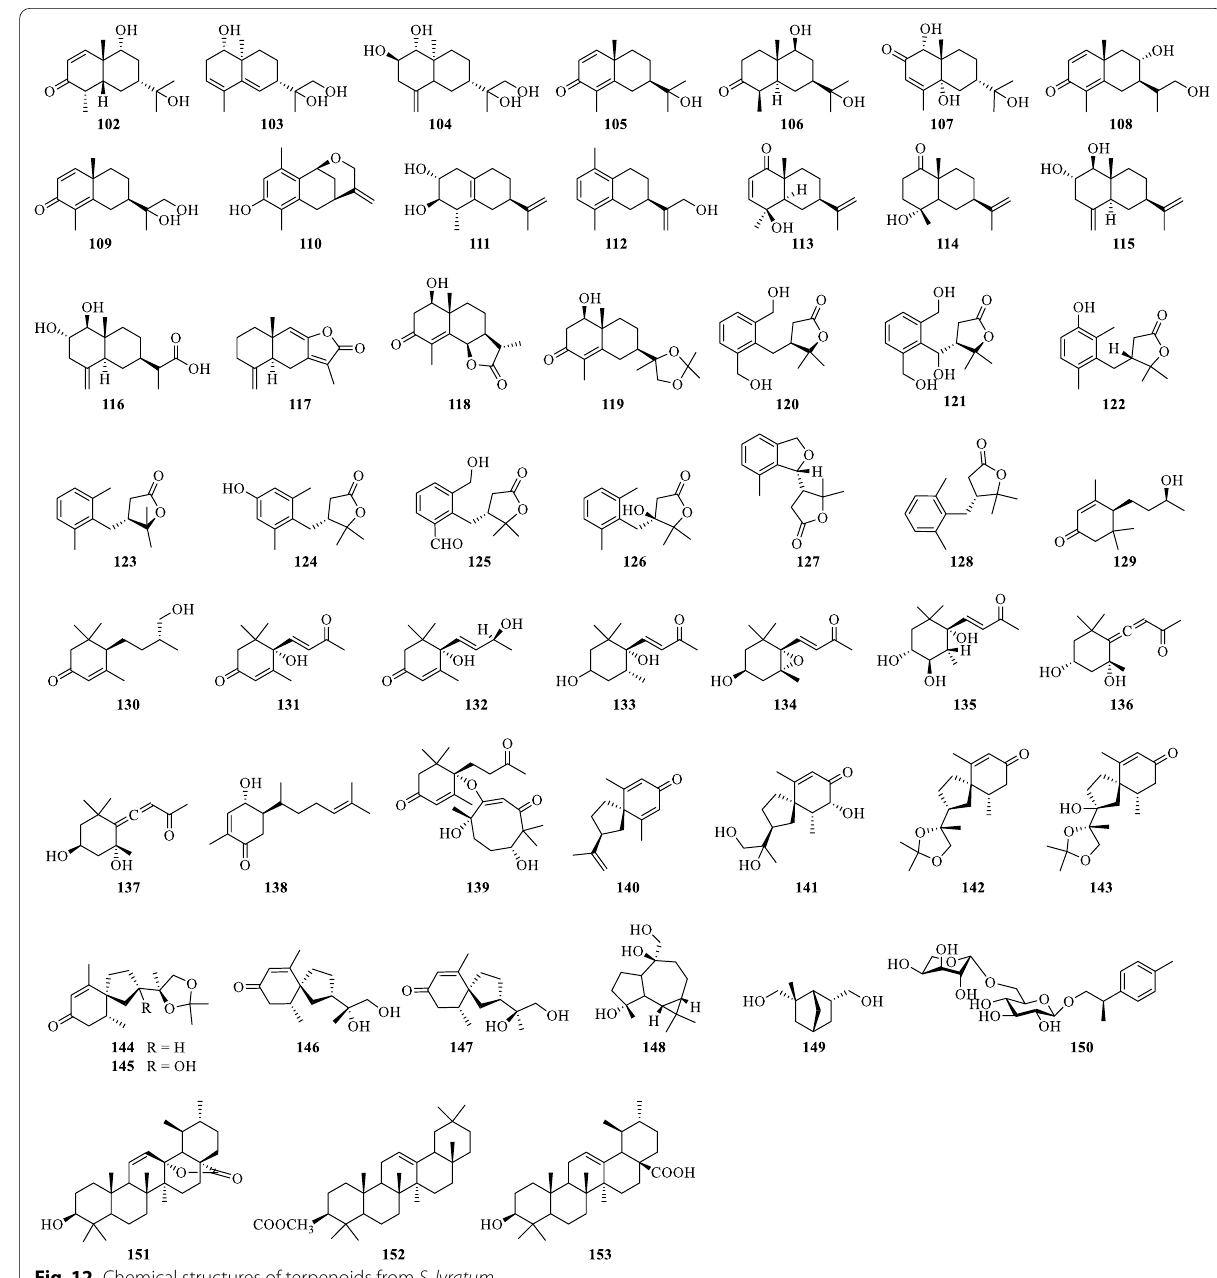
Fig. 12 Chemical structures of terpenoids from S.